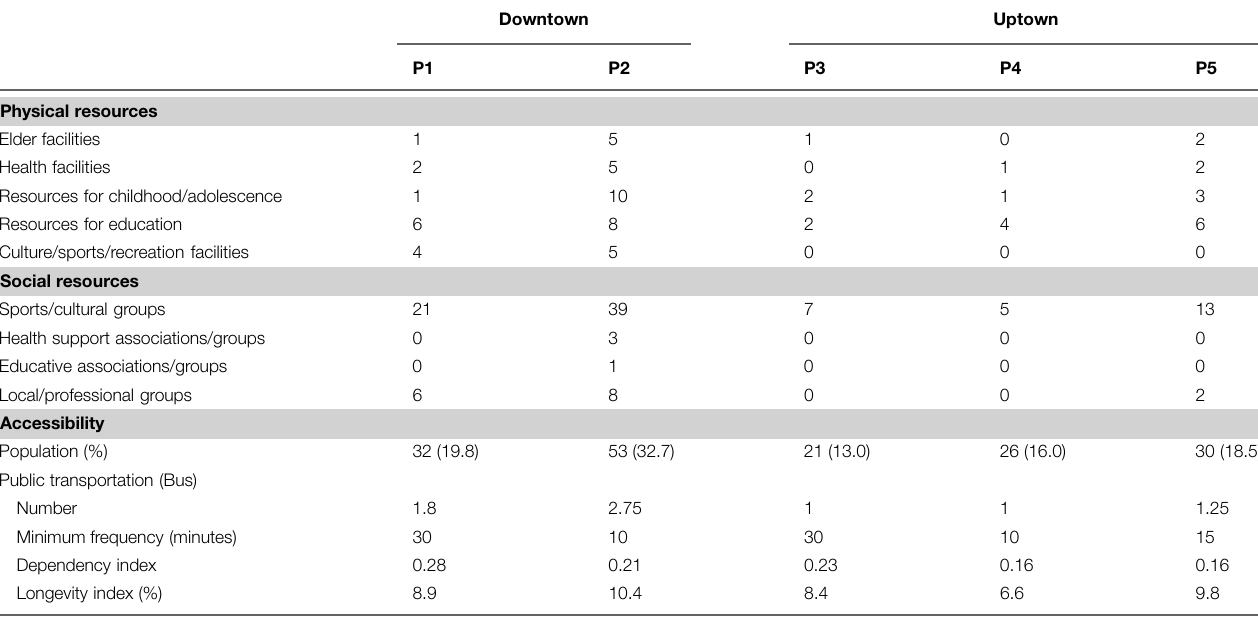
TABLE 2 | Macroenvironmental physical, social, and accessibility resources by